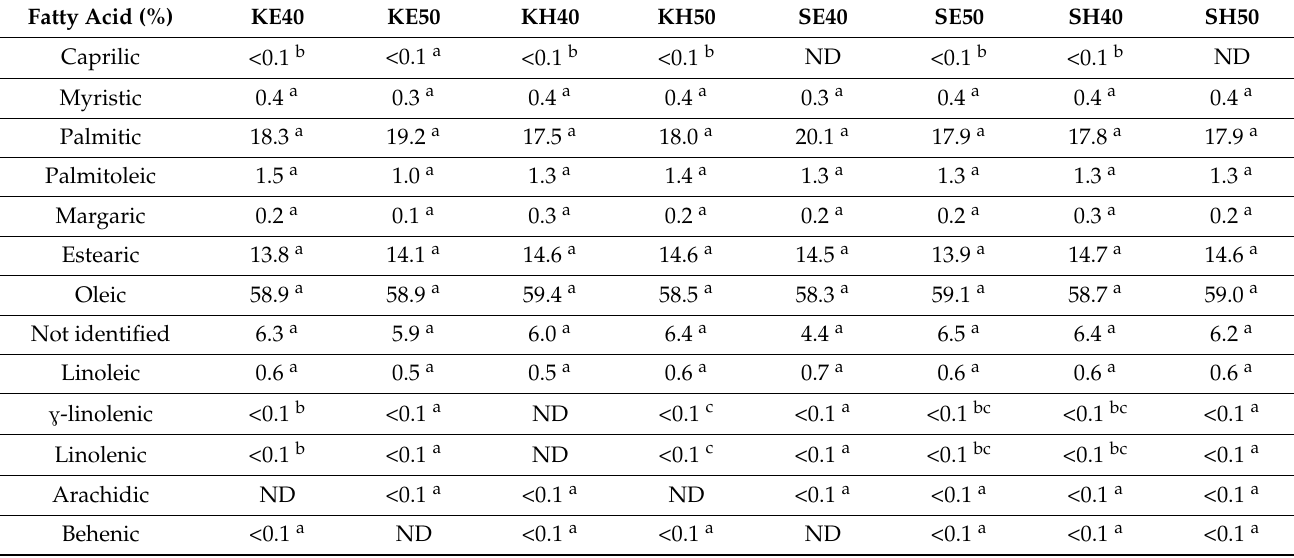
Table 4. Percentage (%) of fatty acids extracted from Moringa according to the treatment